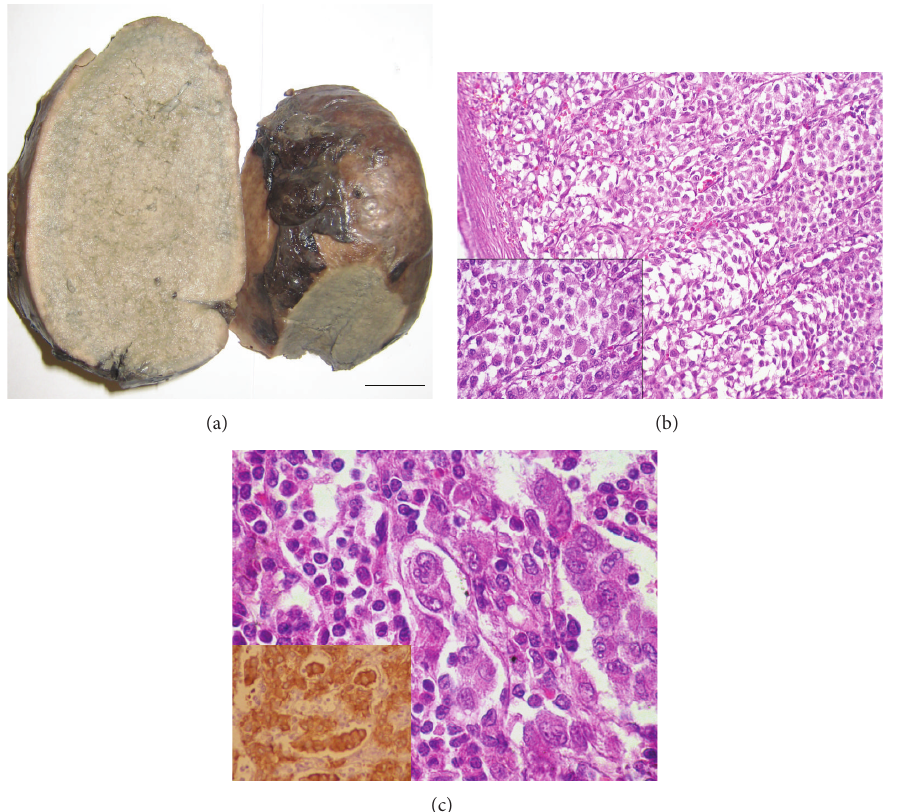
Figure 1: (a) Gross pathology: capsular laceration and hemorrhage and cut sections show diffuse involvement of spleen by creamy homogenous tumoral tissue. (b) Diffuse involvement of spleen by malignant melanoma cells showing fascicular and trabecular pattern (Hematoxylin and Eosin stain, scale bar = 100 𝜇 m). Inset shows rhabdoid type tumor cells (Hematoxylin and Eosin stain, scale bar = 50 𝜇 m). (c) High power shows tumoral cells in red pulp and sinusoids (Hematoxylin and Eosin stain, scale bar = 25 𝜇 m). Inset shows